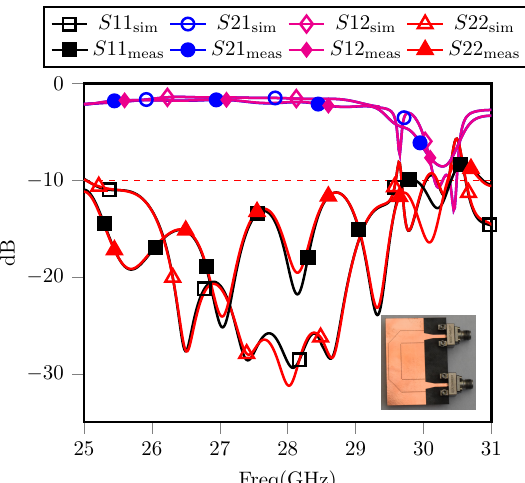
Figure 7. U-shaped bend s-parameters.